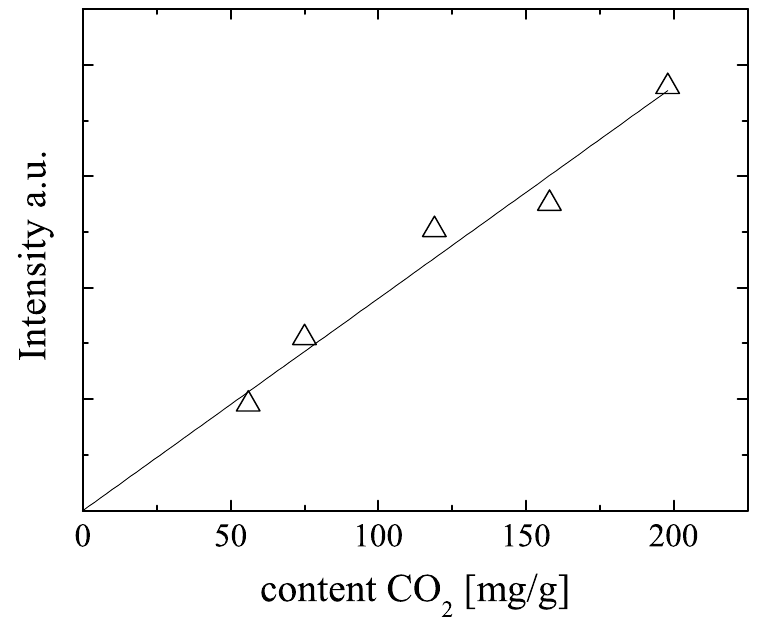
Figure 3. 13 C NMR signal intensity observed with a CPMG sequence in dependence on the volumetrically determined amounts of CO chilled onto the CuBTC mixture samples M1 to 2 M5. The solid line represents the best fit to the data and was used to determine the amount of adsorbed CO from the 13 C NMR signal intensities (see Table 2